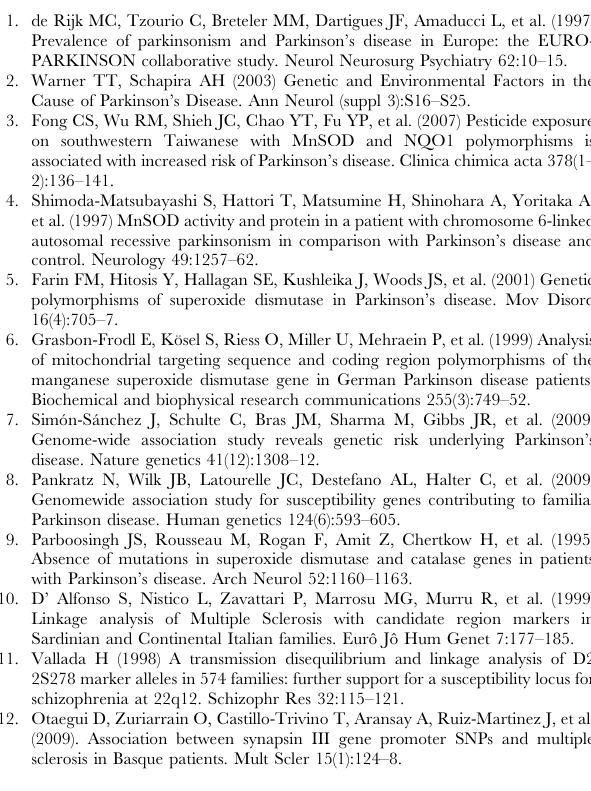
Table S2 Distribution of genotype polymorphisms of MnSOD and SYN III Among Parkinson’s Disease (PD) and Controls in Mainland China. Table S3 Distribution of genotype polymorphisms of MnSOD and SYN III Among Parkinson’s Disease (PD) and Controls in Singapore. Table S4 Distribution of genotype polymorphisms of MnSOD and SYN III Among Parkinson’s Disease (PD) and Controls in the Merged